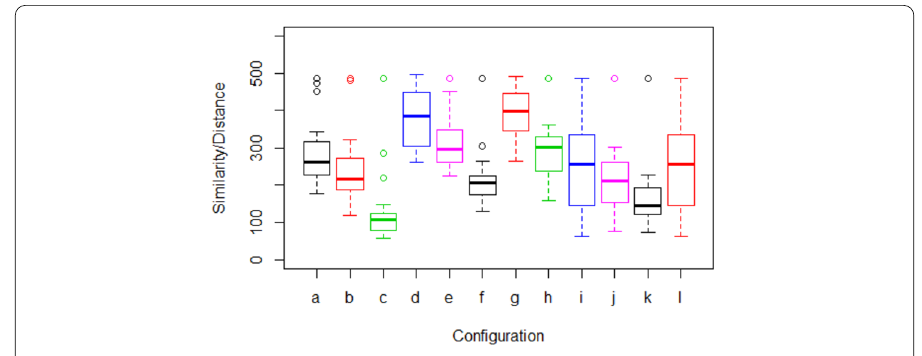
Figure 15 Similarity comparison among different parameter configurations of Fig. 14